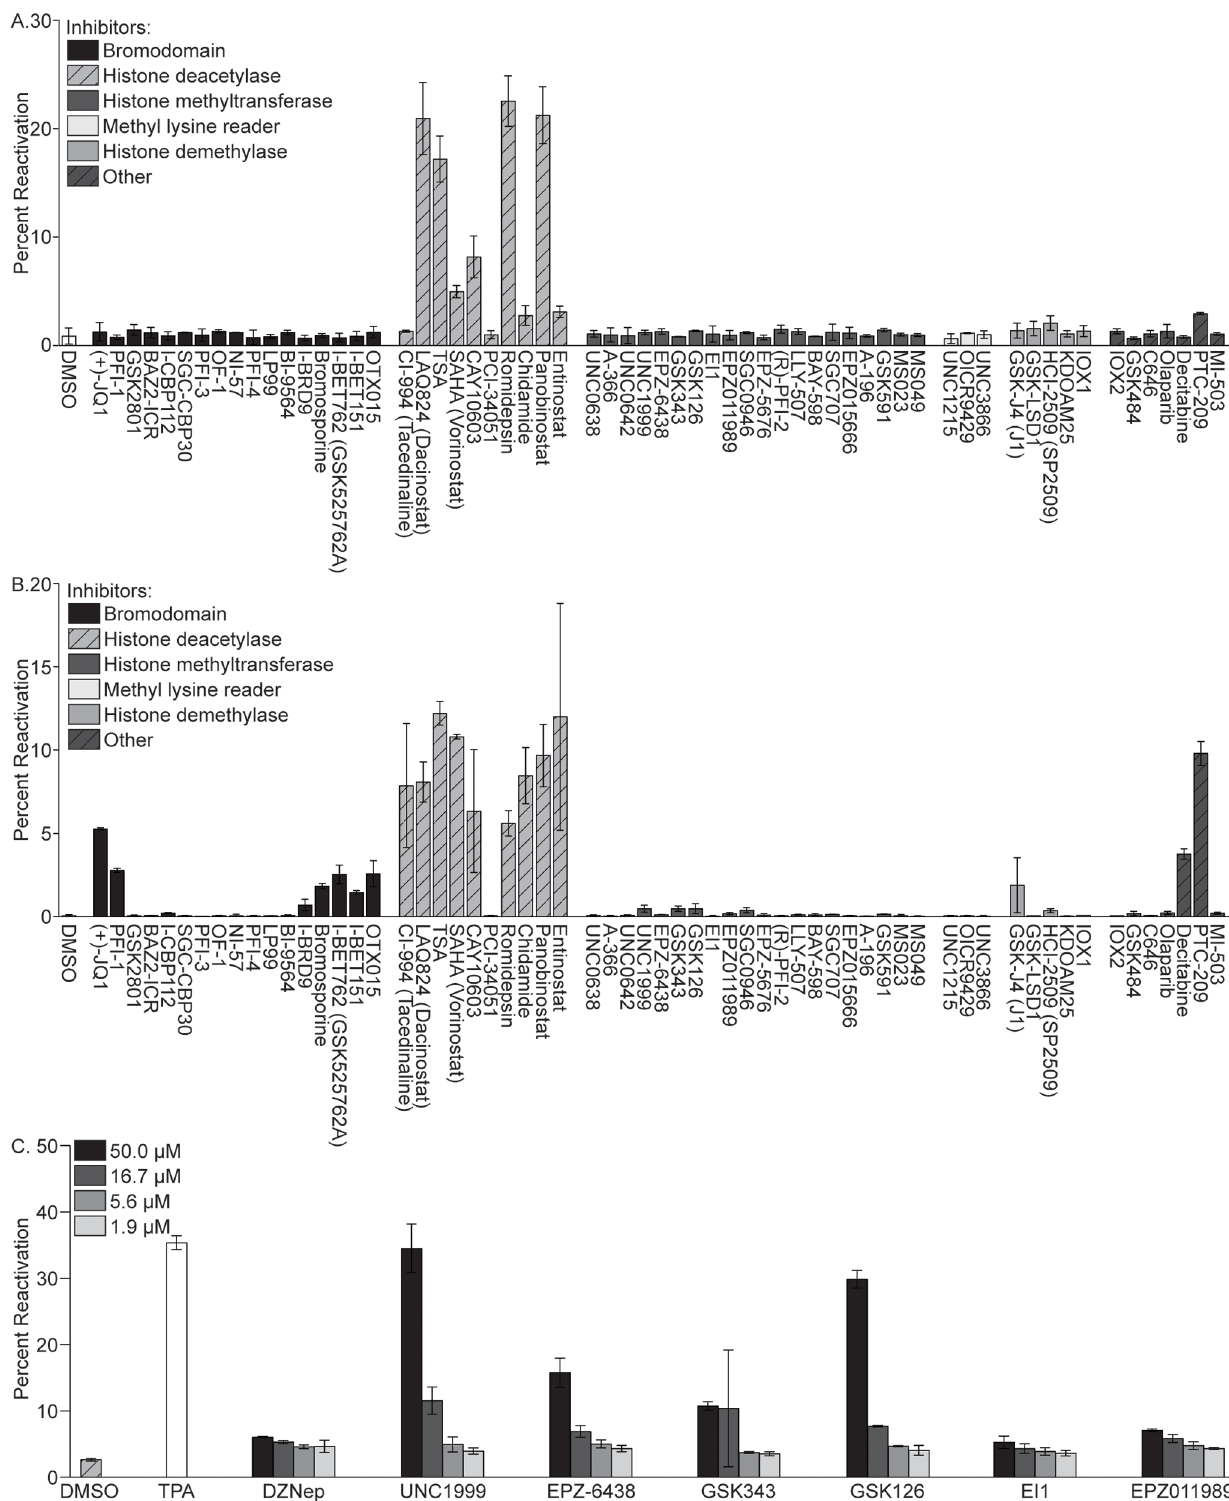
Fig 1. Inhibitor screen for epigenetic regulatory proteins that induce KSHV reactivation from latency. BJAB-KSHV.219 cells were incubated with 1 μM of each compound for 48 hours in (A) or 10 μM of each compound for 120 hours in (B), and the percentage of GFP positive cells expressing RFP (percent reactivation) was determined by FACS analysis. (C) BJAB-KSHV.219 cells were incubated with EZH2 inhibitors at concentrations of 50, 16.7, 5.6,